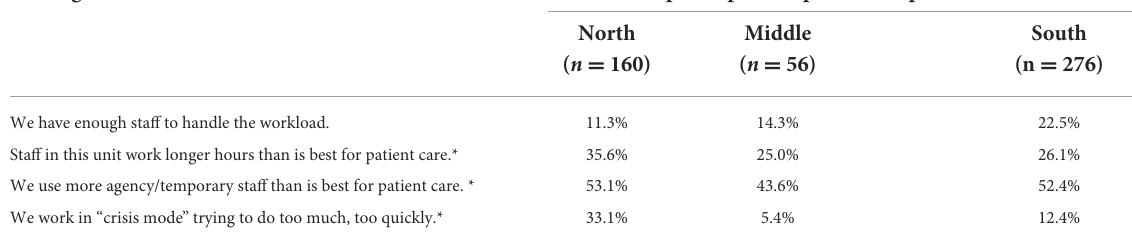
TABLE 5 Percent positive scores of staffing items divided by region.